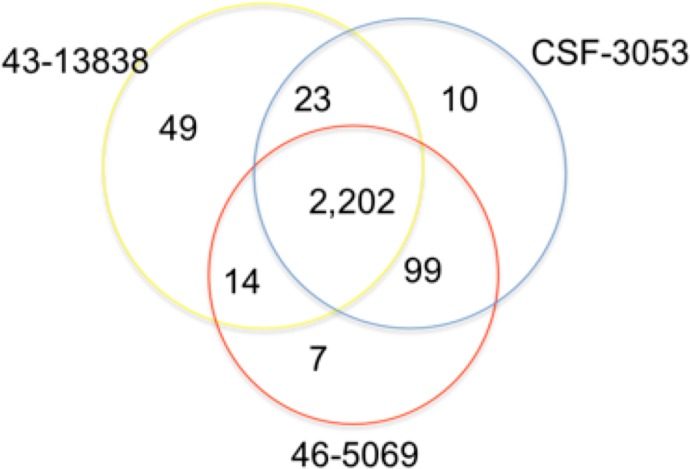
Distribution of single nucleotide polymorphisms in isolates CSF3053, 46-5069 and 43-13838.Venn diagram showing the distribution of the single nucleotide polymorphisms (SNPs) observed in isolates CSF-3053 (blue), 46-5069 (red) and 43-13838 (yellow). CSF3053, 46-5069 and 43-13838 have 10, 7 and 49 unique SNPs respectively. 43-13838 and CSF3053 have 23 SNPs in common, CSF3053 and 46-5069 have 99 SNPs in common, while 43-13838 and 46-5069 have 14 SNPs in common. 2,202 SNPs are common to all isolates.